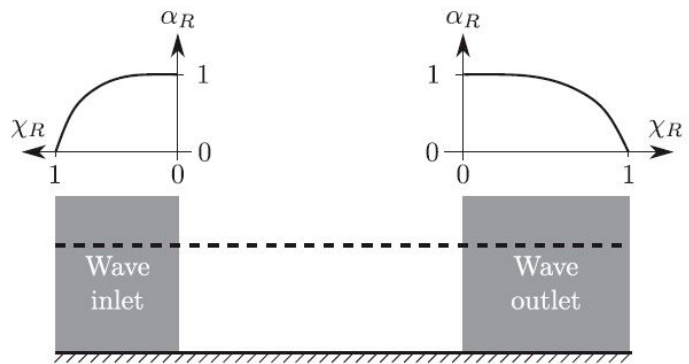
Figure 2. Diagrams of the variation of α R ( χ R ) in relaxation zones (both inlet and outlet) during wave generation and damping calculation in Equation (8).